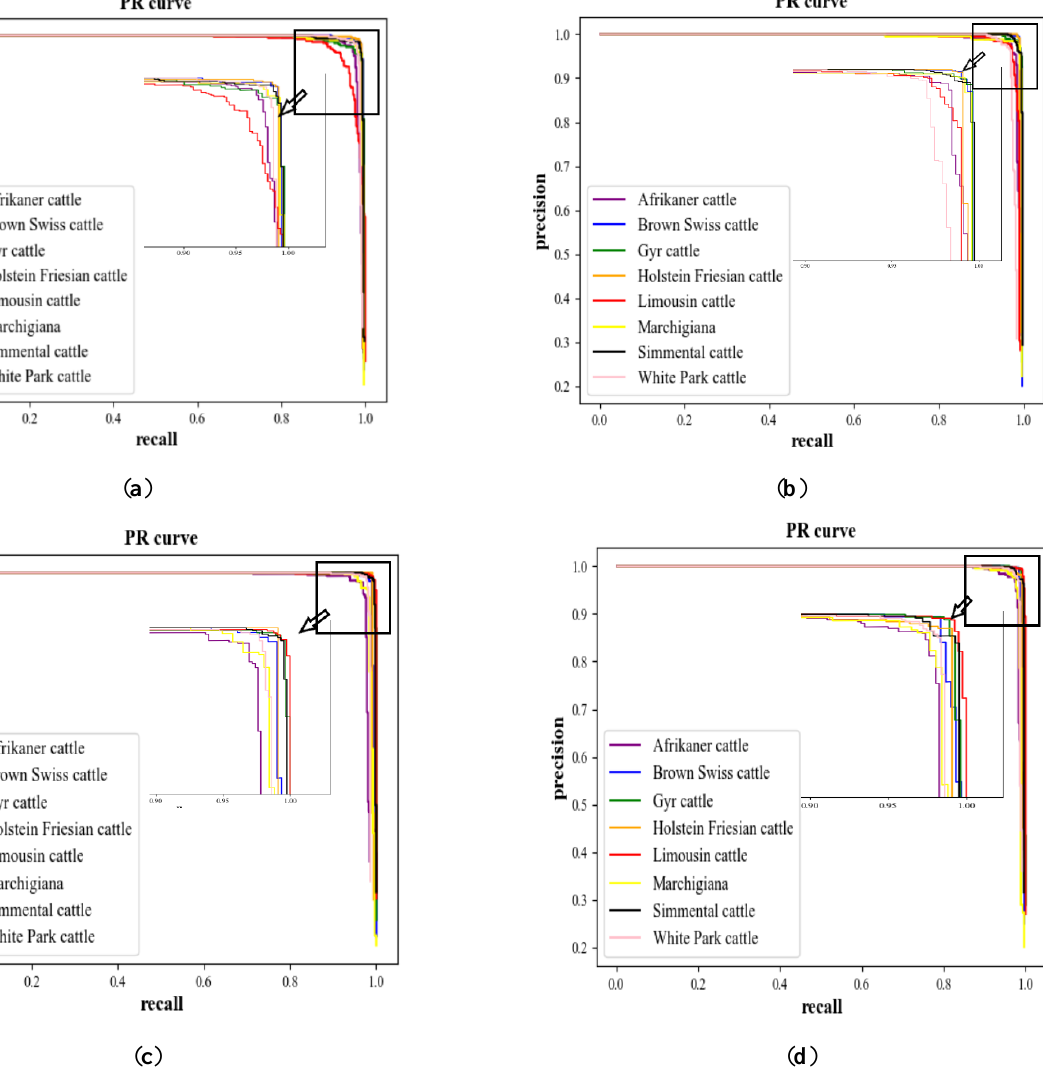
Figure 14. PR curves acquired with network size and IoU _threshold ( a ) 416 × 416, 0.50 ( b ) 416 × 416,